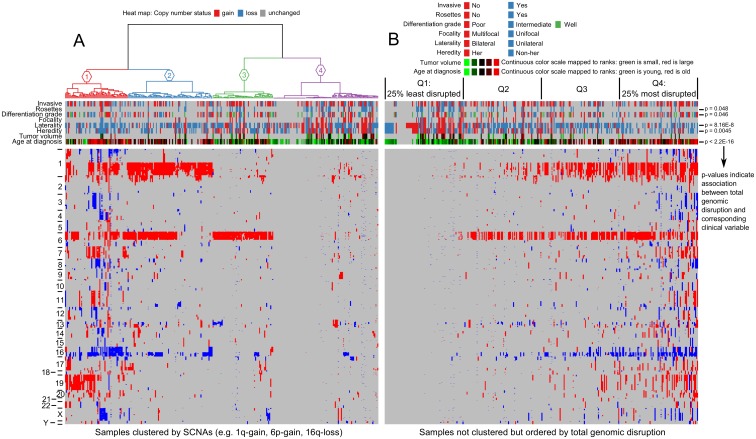
Clustering of genome-wide SCNA.Heat map of genome-wide SCNAs for 310 primary retinoblastoma samples (columns). Gains are indicated in red and losses in blue. (A) Samples are ordered by unsupervised hierarchical clustering (UHC) visualized by the dendrogram on top. The dendrogram was pruned in 4 UHC-groups indicated by UHC-group numbers and colored branches. Color-coded sample information: invasion: red = not-invasive, blue = invasive; rosettes: red = no rosettes, blue = rosettes; differentiation: red = poor, blue = moderate, green = well; focality: red = multifocal, blue = unifocal; laterality: red = bilateral, blue = unilateral; heredity: red = hereditary, blue = non-hereditary, tumor volume by MRI and age at diagnosis: continuous green-to-red scale where green means small tumors diagnosed at early age and vice versa. (B) Instead of ordering by UHC, samples are ordered based on total genomic disruption by SCNAs. P-values indicate the significance of association between total genomic disruption and the clinical variable.